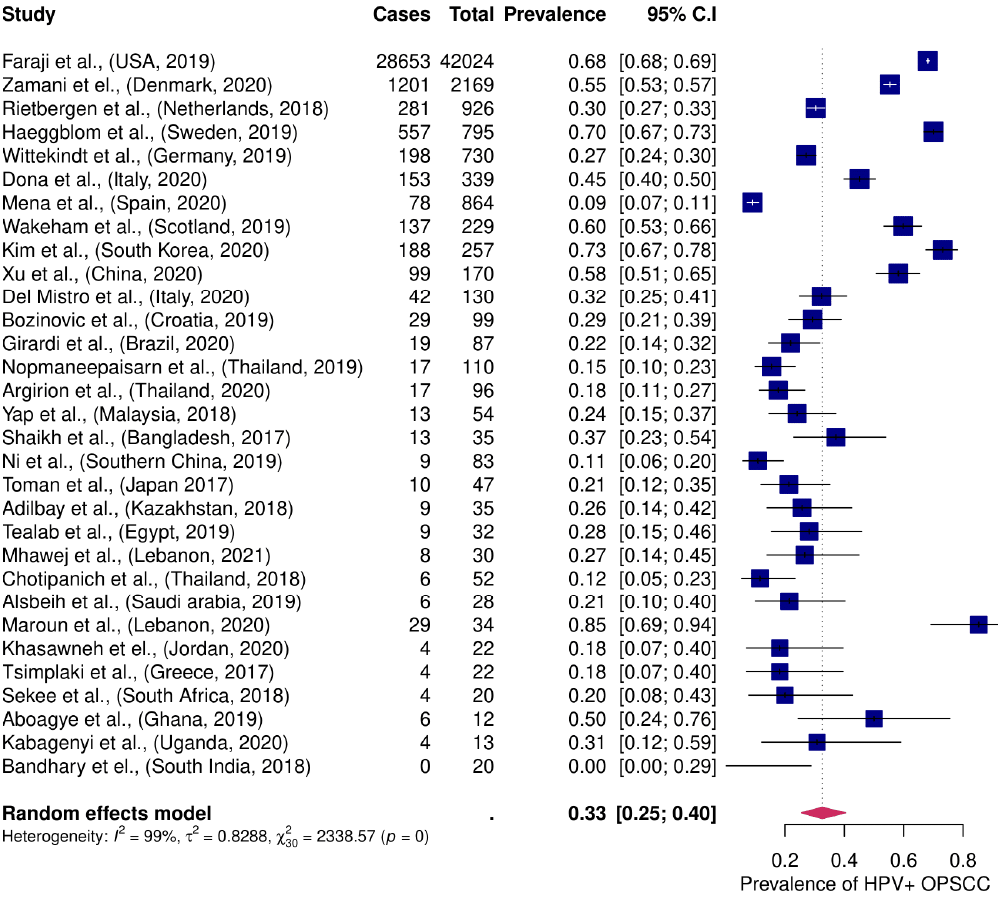
Figure 2. Proportion meta-analysis of HPV+ OPSCC in enrolled studies. Occurrence of HPV+ OPSCC worldwide among patients with OPSCC. OPSCC: oropharyngeal squamous cell carcinoma. HPV +: human papillomavirus-positive.